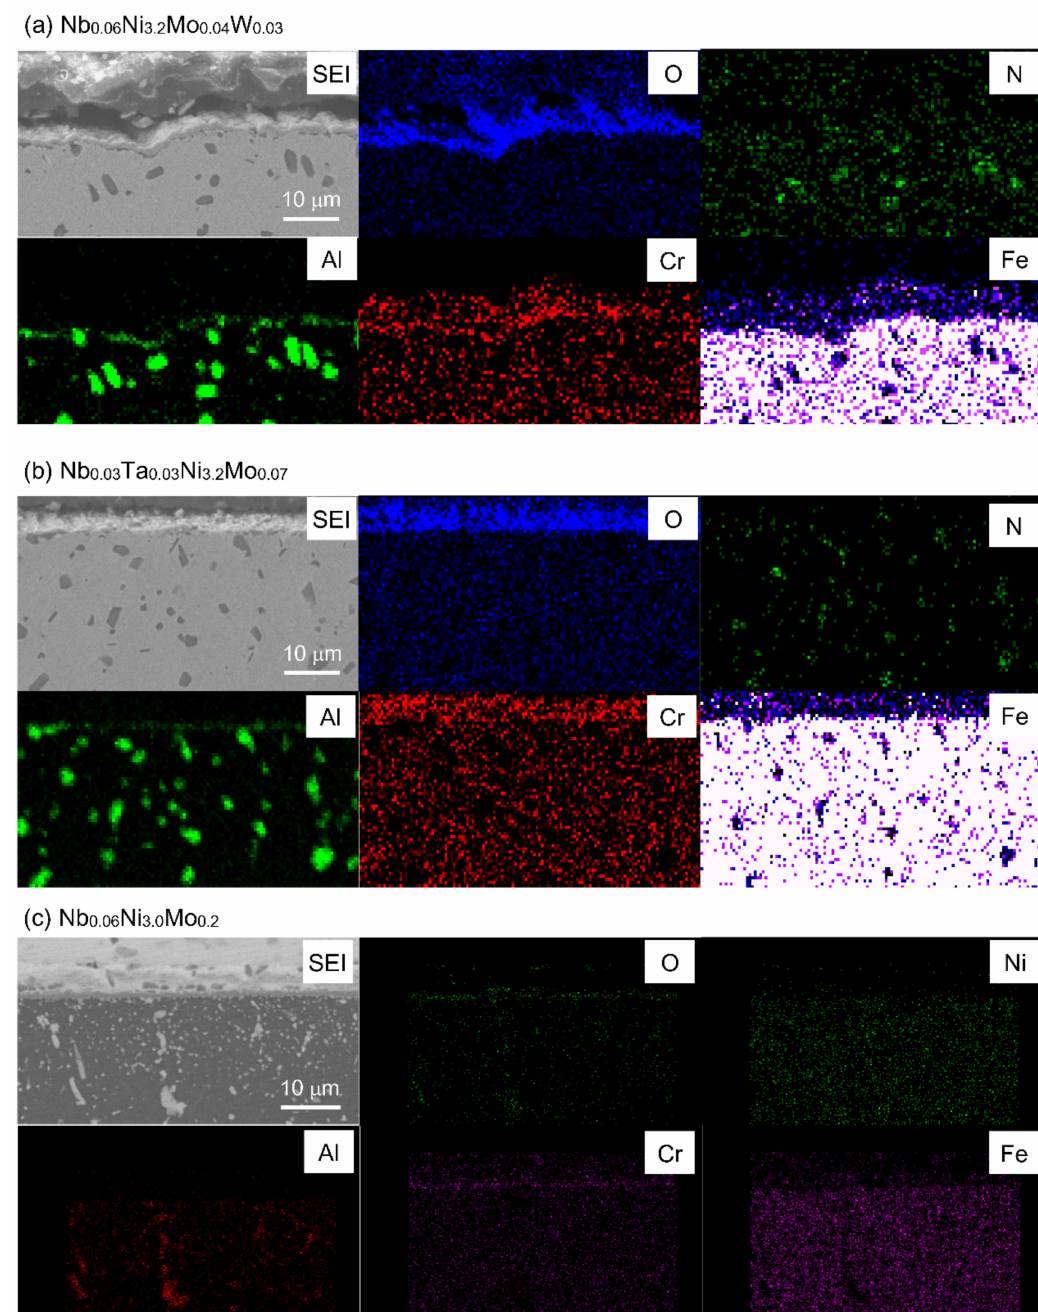
Figure 10. SEM-EDS cross-section elemental mapping of typical W-containing, Ta-containing and (Ta, W)-free alloys. ( a ): Nb 0.06 Ni 3.2 Mo 0.04 W 0.03 , ( b ): Nb 0.03 Ta 0.03 Ni 3.2 Mo 0.07 , ( c ): Nb 0.06 Ni 3.0 Mo 0.2